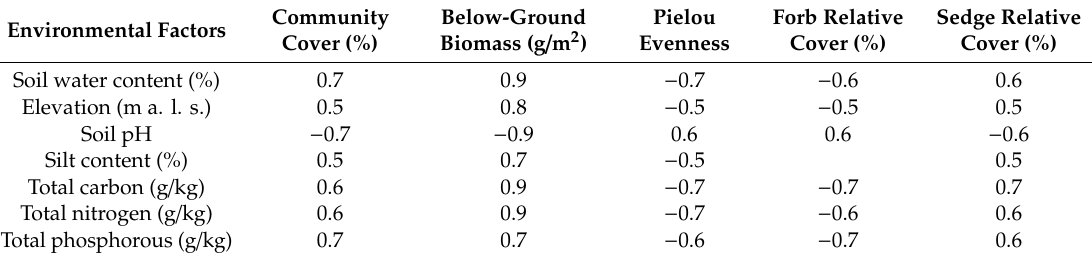
Table 4. Significant correlations ( p < 0.05) between vegetation and environmental factors. N = 22, including sites in areas of permafrost and seasonally frozen ground.